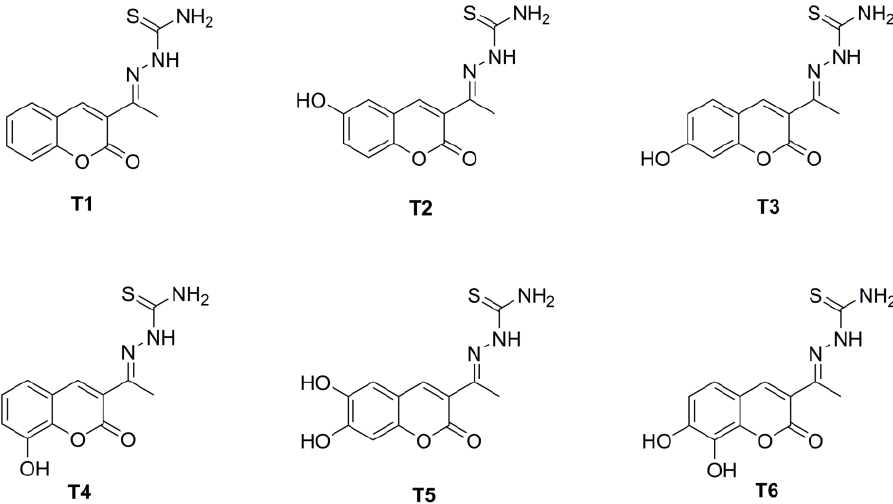
Figure 1. Structures and acronyms of the studied compounds.